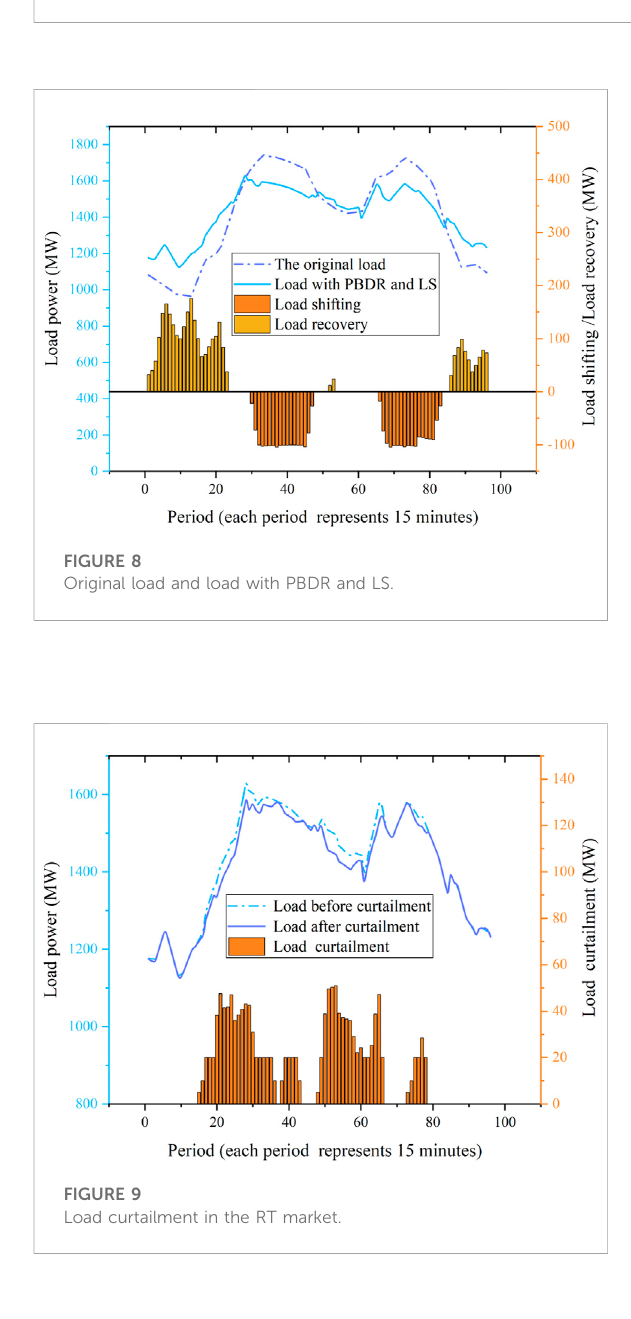
FIGURE 7 Solution fl owchart.